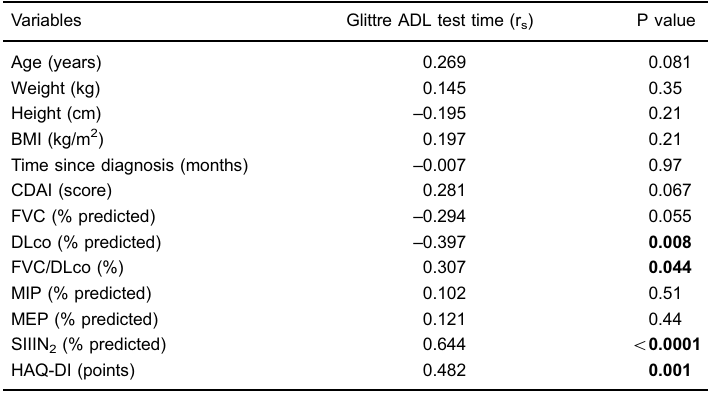
Table 2. Spearman ’ s correlation coef fi cients for the association of Glittre ADL-test time with demographic, anthropometric and clinical data, lung function, and physical